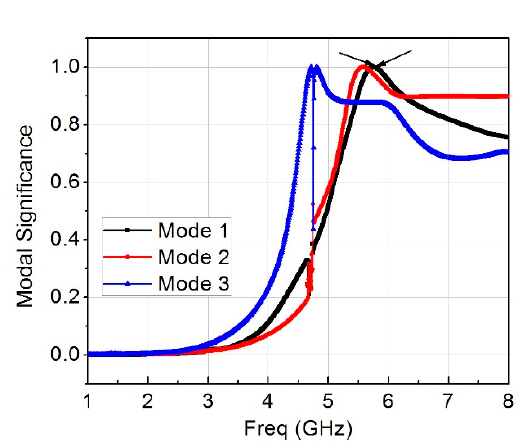
Figure 12. Modal significance of three modes at 5.8 GHz.